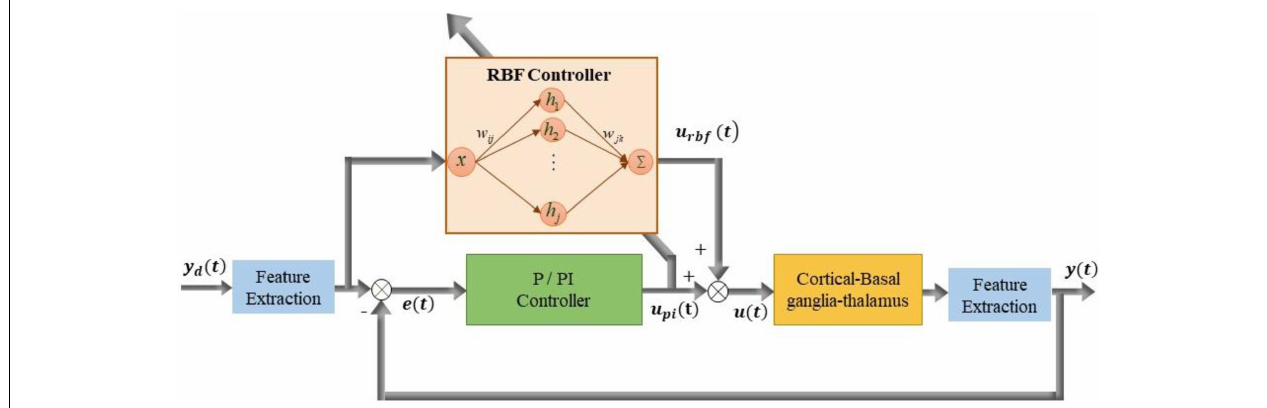
FIGURE 2 | Block diagram of improved supervisory algorithm under the guidance of radial basis function (RBF) network. Stimulation signal u ( t ) is applied to GPi model neurons and the simulated beta power y ( t ) is obtained from LFP of the GPi. The stimulation signal u ( t ) is determined by the joint action of the P controller output u p ( t ) and RBF network controller output u rbf ( t ) .